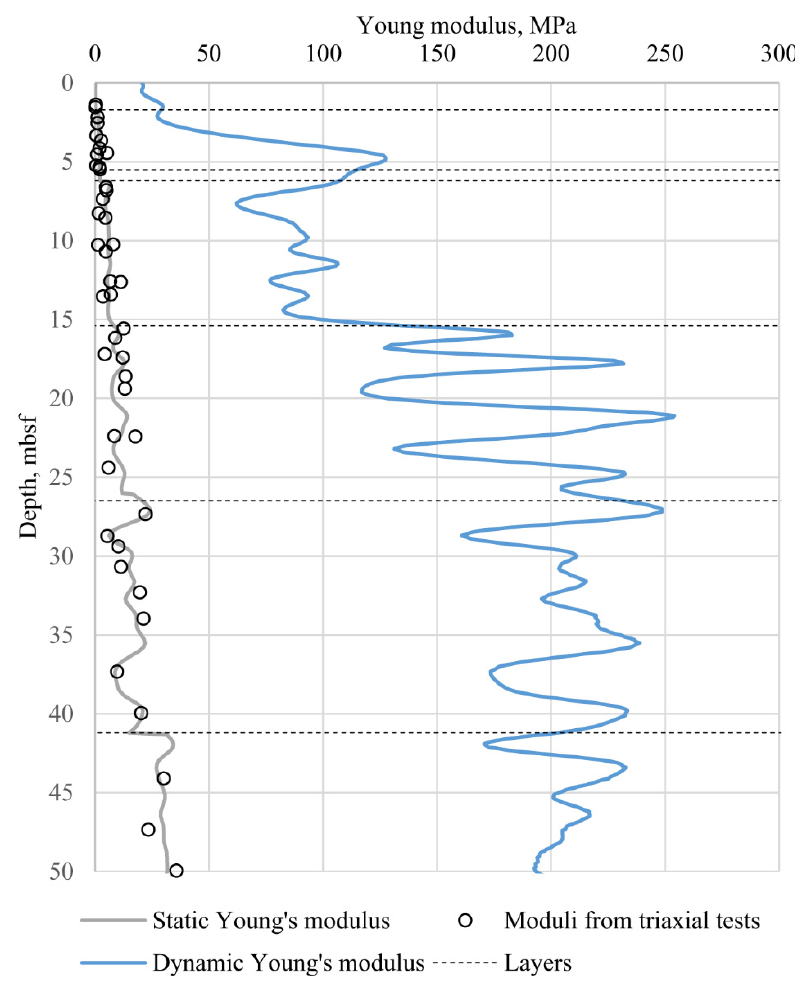
Figure 4. Young’s modulus for the studied well.